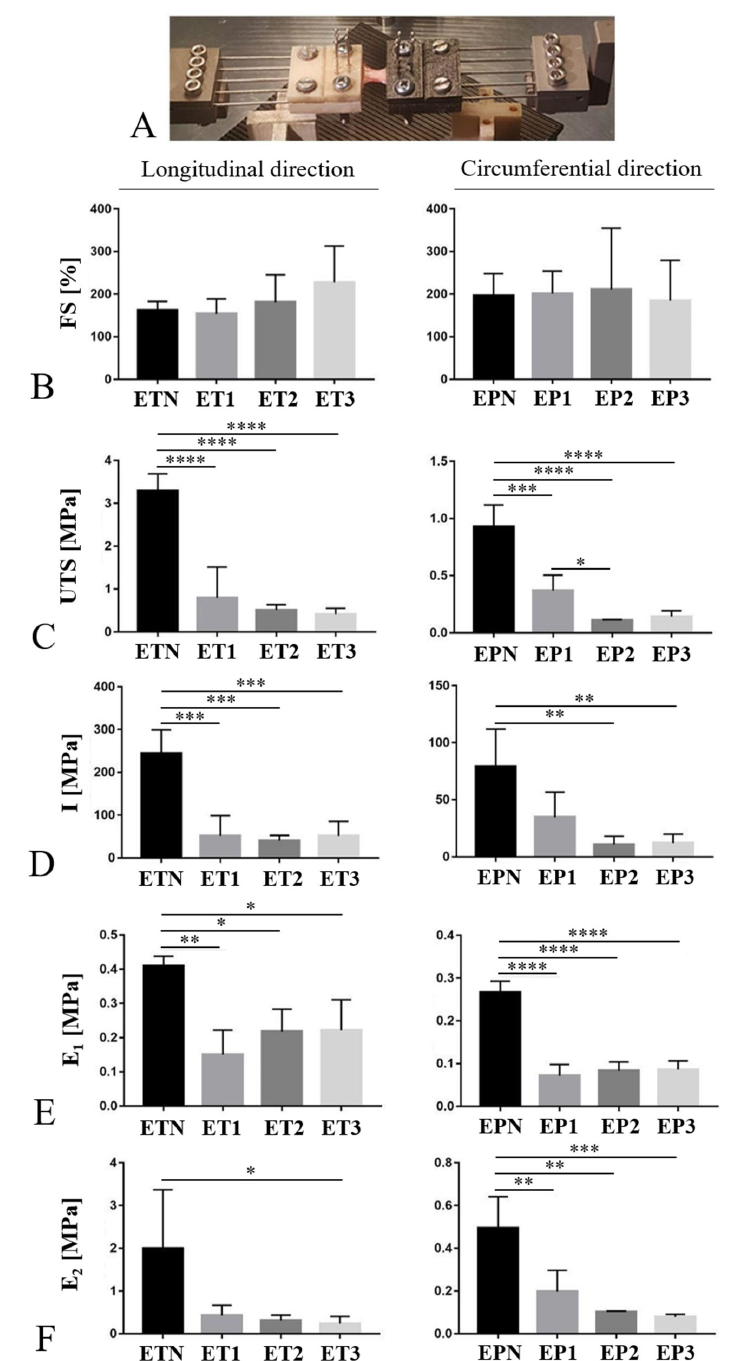
Figure 7. Biomechanics of decellularized esophagi. Mechanical properties of esophageal patches before (EPN) and after decellularization with Protocols Nos. 1 (EP1), 2 (EP2) and 3 (EP3). The tensile force was applied using a custom-made apparatus ( A ) along both longitudinal and circumferential directions to measure Failure Strain (FS) ( B ), Ultimate Tensile Strength (UTS) ( C ) and toughness (I) ( D ). Young’s modules E 1 ( E ) and E 2 ( F ) were also calculated as the slope of the stress–strain curves at a deformation of 1–10% and 80–90%, respectively (* p <0.05, ** p <0.01, *** p <0.001, **** p < 0.0001).